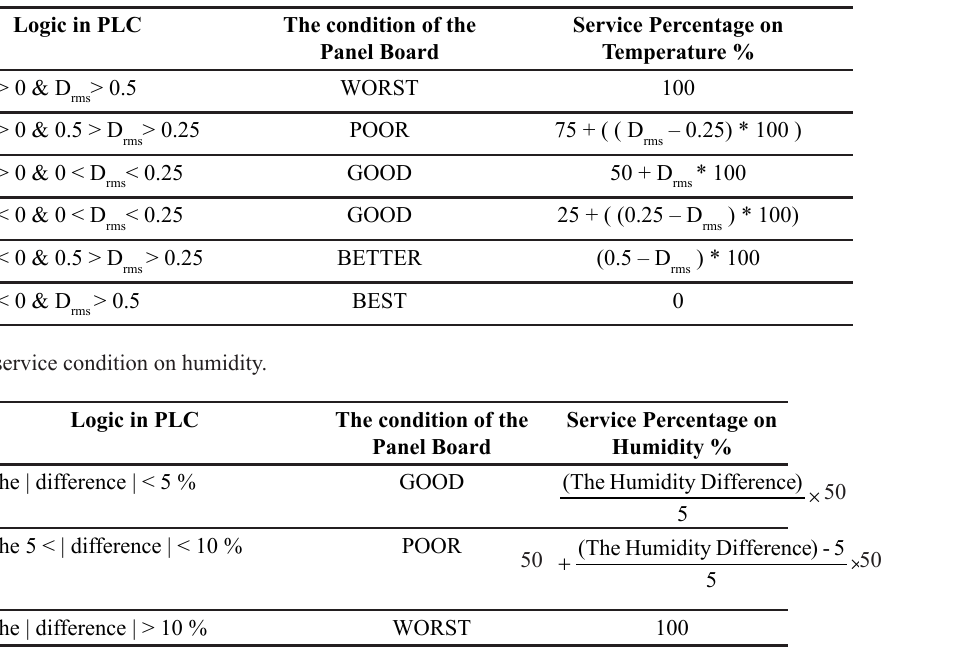
Table 5: PLC Logic for service condition on temperature. Logic in PLC The condition of the Service Percentage on Panel Board